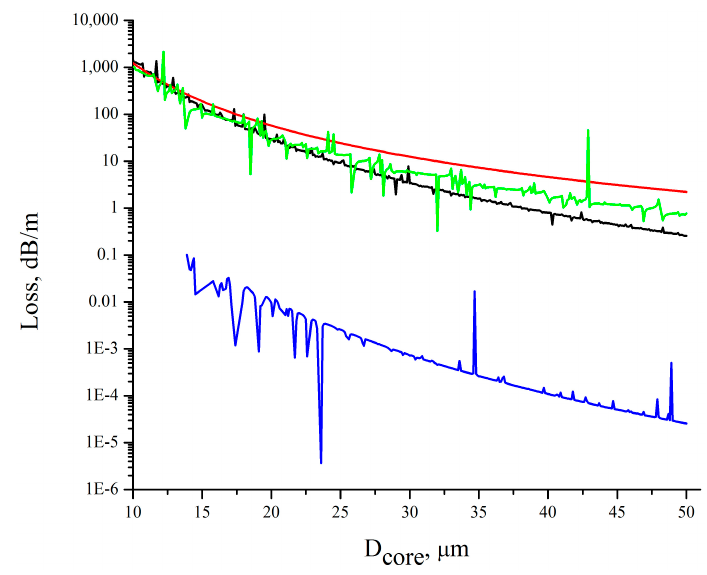
Figure 1. Waveguide loss dependence on the value of the air core diameter for a silica glass capillary (red), a silica glass octagon waveguide (green), a silica glass square waveguide (black), and a silica glass negative curvature microstructure with ten capillaries in the cladding (blue).